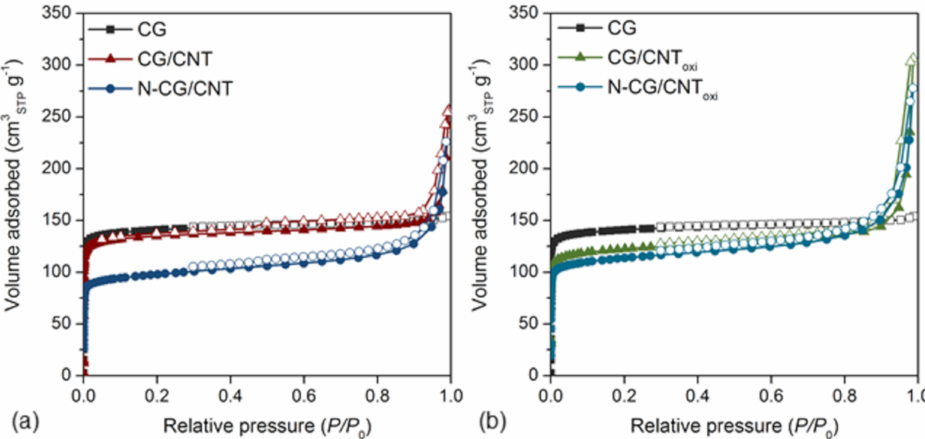
Figure 1. N 2 adsorption–desorption isotherms of carbonized glucose and undoped and N-doped carbon composites prepared by introducing a carbon nanotube (CNT; a ) and oxidized CNT ( b ). Filled symbols: adsorption; open symbols: desorption. Table 1. Textural properties of carbonized glucose and undoped and N-doped carbon composites.